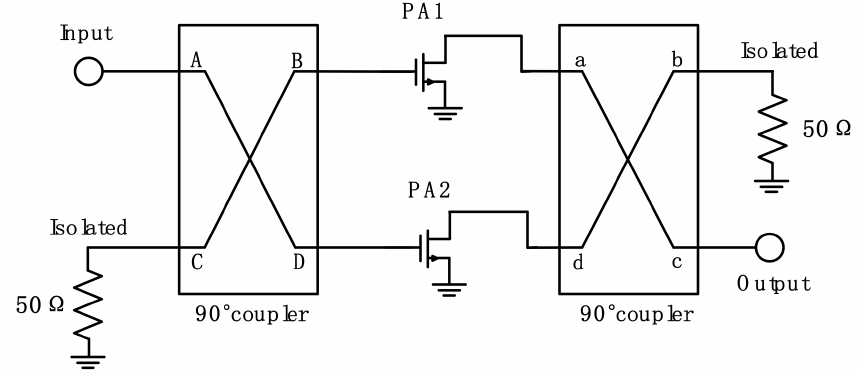
Figure 17. Balanced amplifier circuit schematic